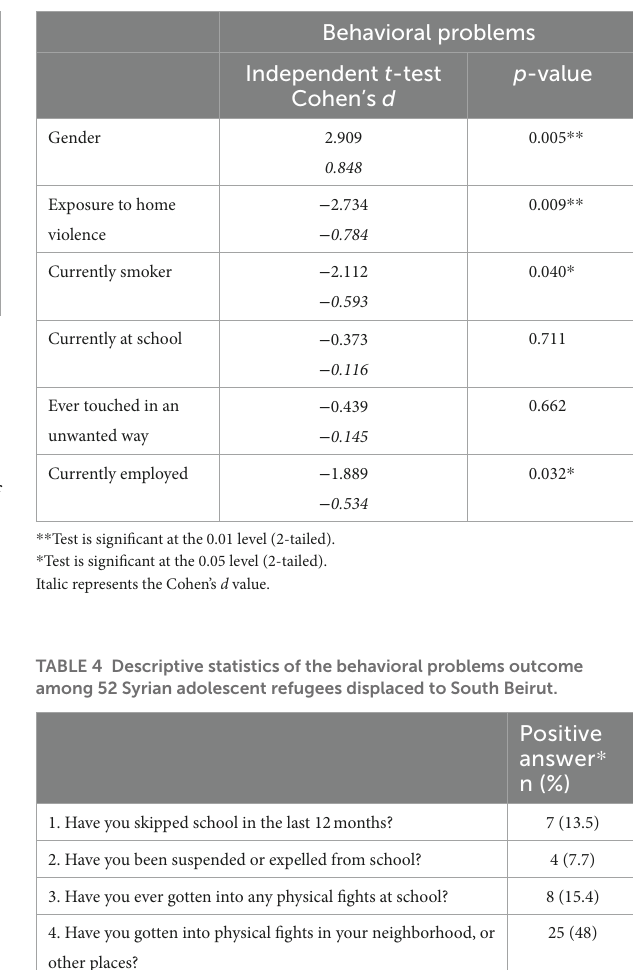
TABLE 2 Factors found associated to positive screen for depression among 52 Syrian adolescent refugees displaced to South Beirut interviewed following the HEEADSSS framework—2019.